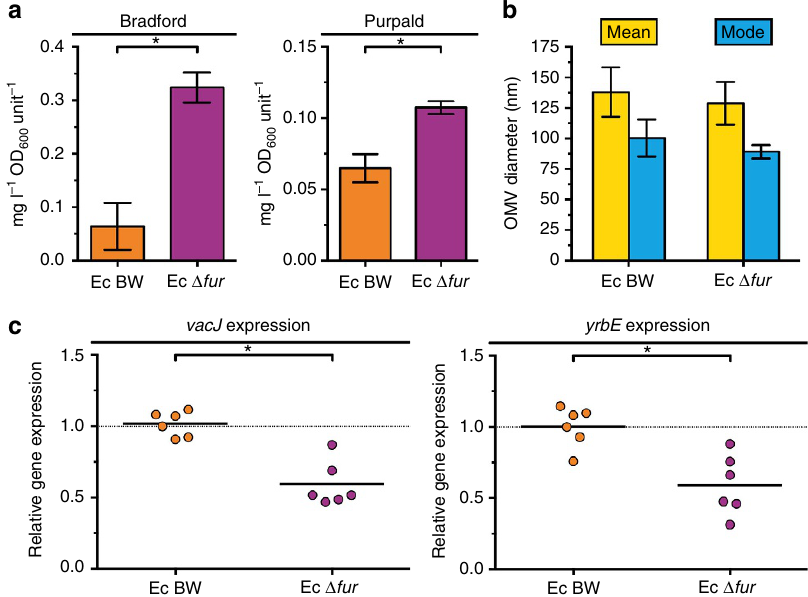
Figure 6 | Regulation of vacJ and yrbE expression in E. coli . ( a ) OMVpreparations derived from equivalent OD 600 units of cultured wild-type (Ec BW) and deletion mutant (Ec D fur ) were analysed for total protein (Bradford) and lipooligosaccharide (Purpald). Mean values with s.e.m. are shown ( n ¼ 6 biological replicates). ( b ) Distributions of OMV sizes produced by the strains were determined by nanoparticle tracking analysis. Mean values with s.d. of mean and mode OMV diameter sizes within respective OMV preparations are shown ( n ¼ 6 biological replicates). ( c ) Relative expressions of vacJ and yrbE in Ec BW and Ec D fur were determined by qRT-PCR. Horizontal bars highlight the mean of each data set ( n ¼ 6 biological replicates). Dotted lines indicate a relative gene expression of 1. ( a , c ) Significant differences between the data sets are marked by asterisks ( P o 0.05; unpaired t -test).